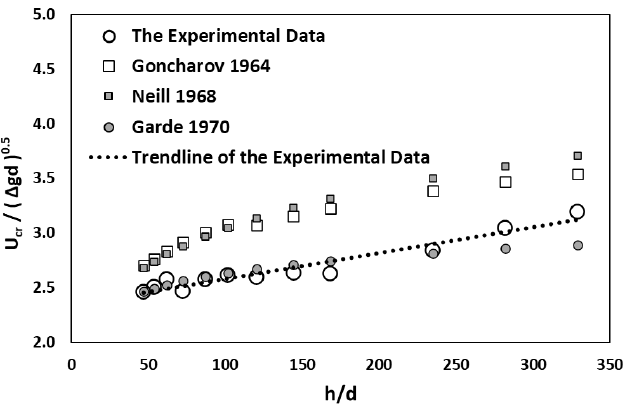
Figure 6. Relationship between ℎ